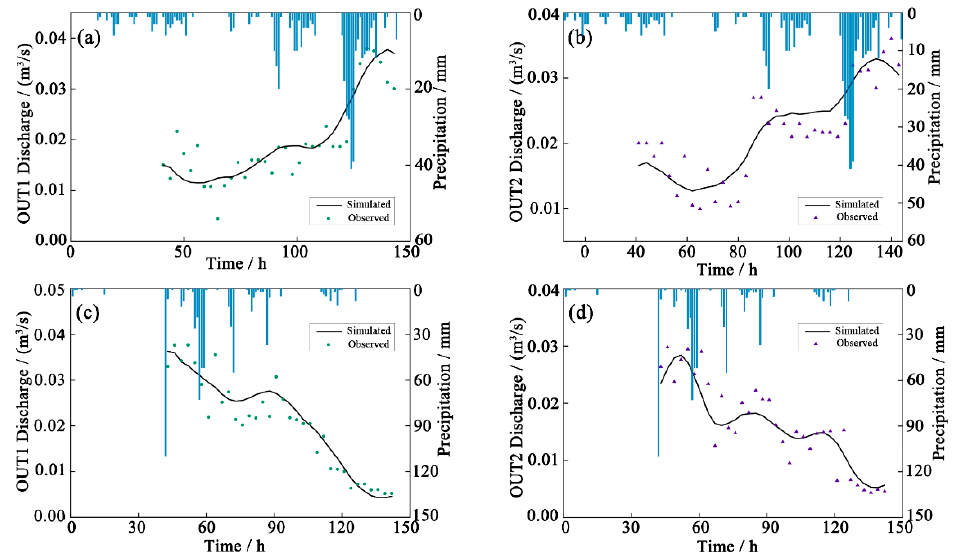
Figure 3. Calibration ( a , b ) and validation ( c , d ) results for runoff in the SWMM model.